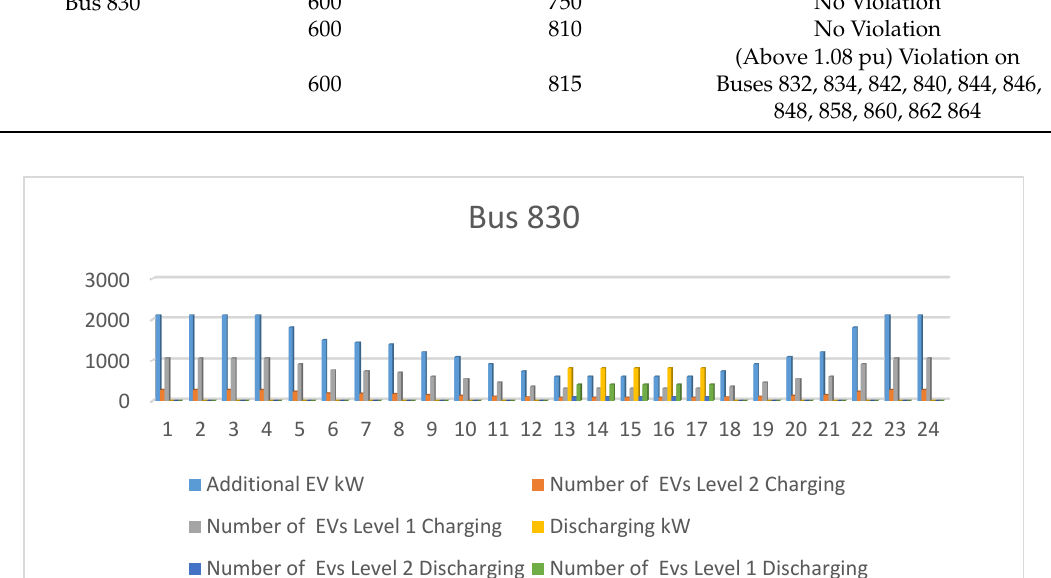
Figure 11 . Case 3 Additional Charging/Discharging Load and number of EVs on Bus 830. Figure 11. Case 3 Additional Charging/Discharging Load and number of EVs on Bus